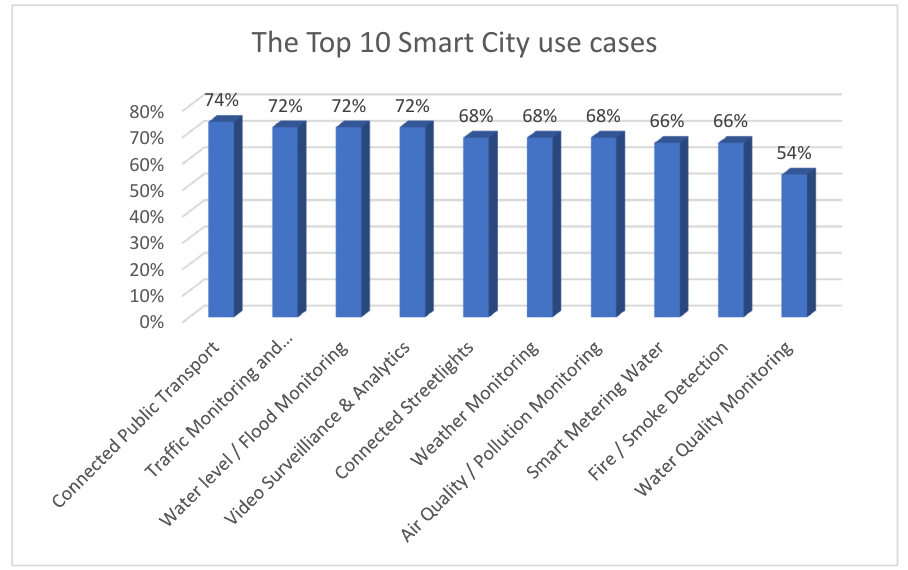
Figure 1. Top 10 Smart City use cases (Source: https://iot-analytics.com/top-10-smart-cityuse-cases-prioritized-now) (accessed on 20 November